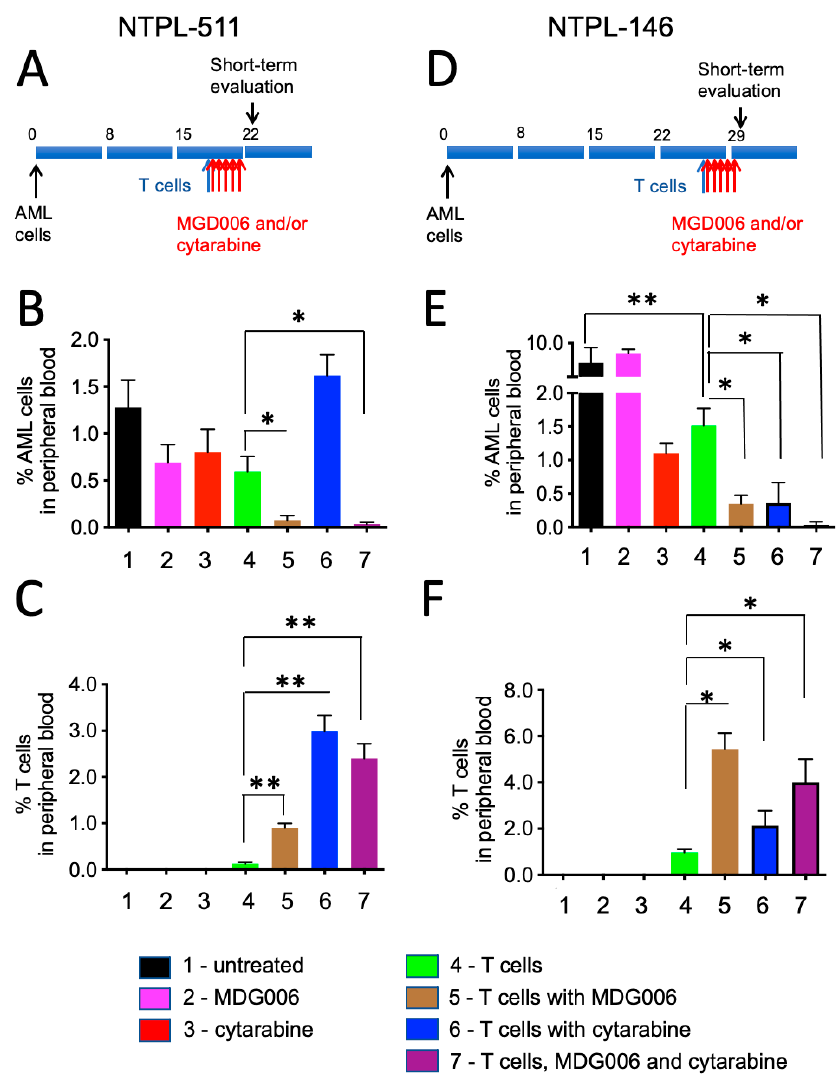
Figure 2. Short-term effect of MGD006 treatment in pediatric AML PDX models. ( A , D ) Schematic showing timeline of treatment. ( B , C ) Peripheral blood was collected on day 22 (treatment ended day 21) from NTPL-511 mice to determine AML (CD45+ CD3 − ) and T-cell (CD45+ CD3+) percentage by flow cytometry. ( E , F ) Peripheral blood collected from NTPL-146-transplanted mice on day 31 (treatment completed day 30) was used for calculating percentage of AML and T cells by flow cytometry. * p < 0.05, ** p < 0.01. The X-axis in B–F indicates treatment group numbers (1) untreated, (2) MDG006, (3) cytarabine, (4) T cells, (5) T cells with MGD006, (6) T cells with cytarabine, and (7) T cells with concurrent administration of cytarabine and